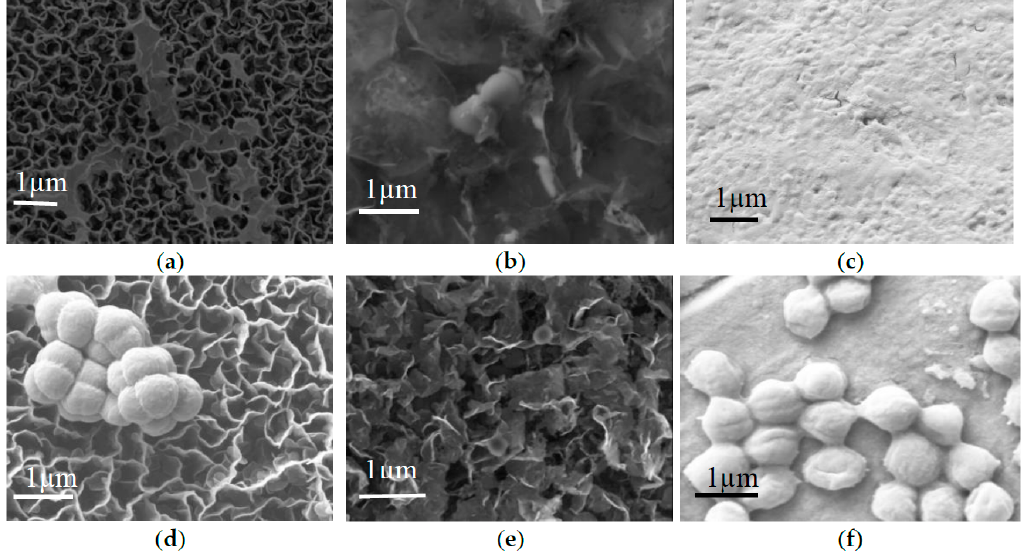
Figure 4 . Representative SEM images of E. coli cell attachment on the surfaces of ( a ) methane-derived (GNW_M) and ( b ) bagasse-derived (GNW_B) graphene, and ( c ) pure copper substrate after 4 h of incubation at 22 °C. SEM images of S. aureus cell attachment on the surfaces of ( d ) GNW_M, ( e ) GNW_B, and ( f ) copper after incubation under the same conditions.